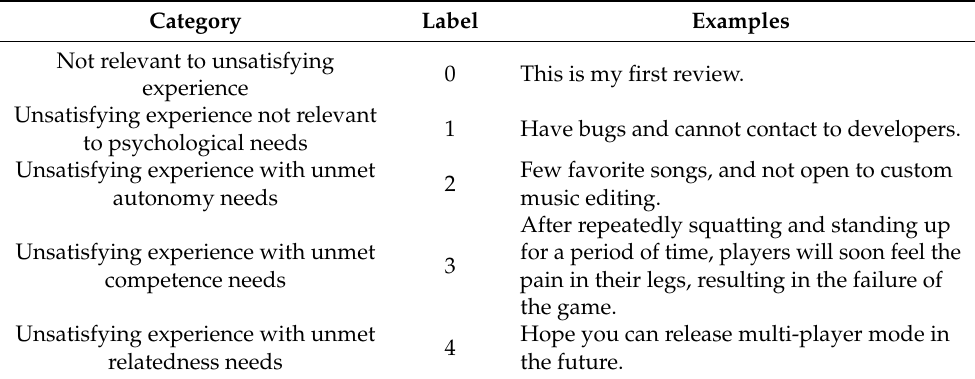
Table 1. Categories and labelling rules.